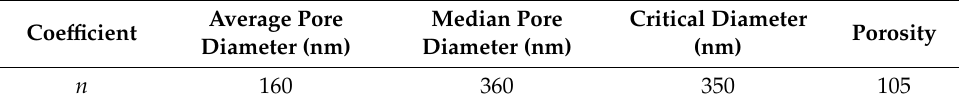
Table 6. Parameters n for di ff erent pore parameters.